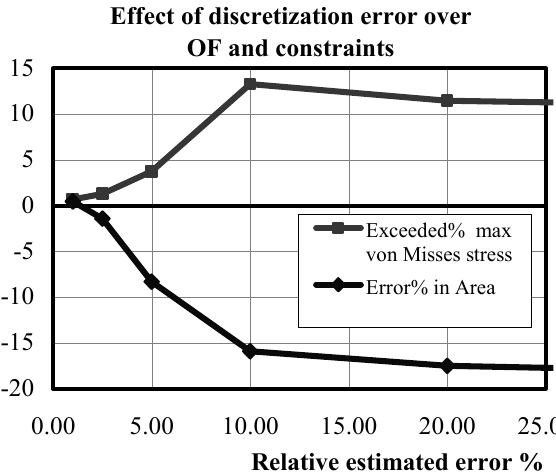
Fig. 4. Influence of γ over the evolution of the error in the objective function with respect to the analytical solution